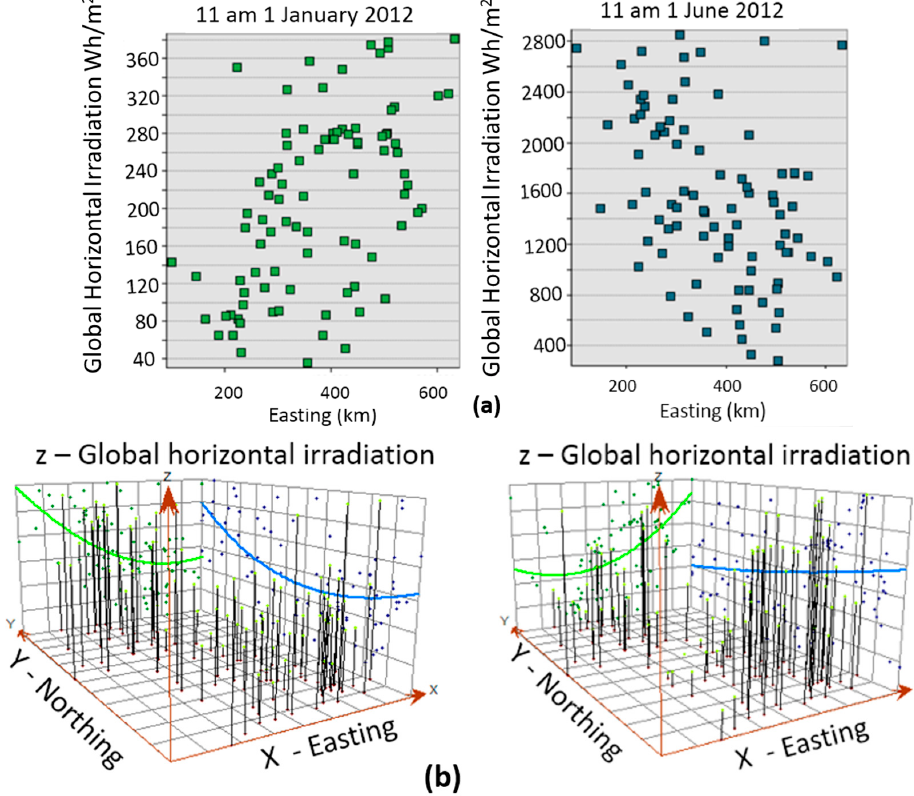
Figure A1. ( a ) Graphs and ( b ) trend plots of global horizontal irradiation (Wh/m 2 ) plotted against Easting of Weather Station (graph) and Easting/Northing (trend).